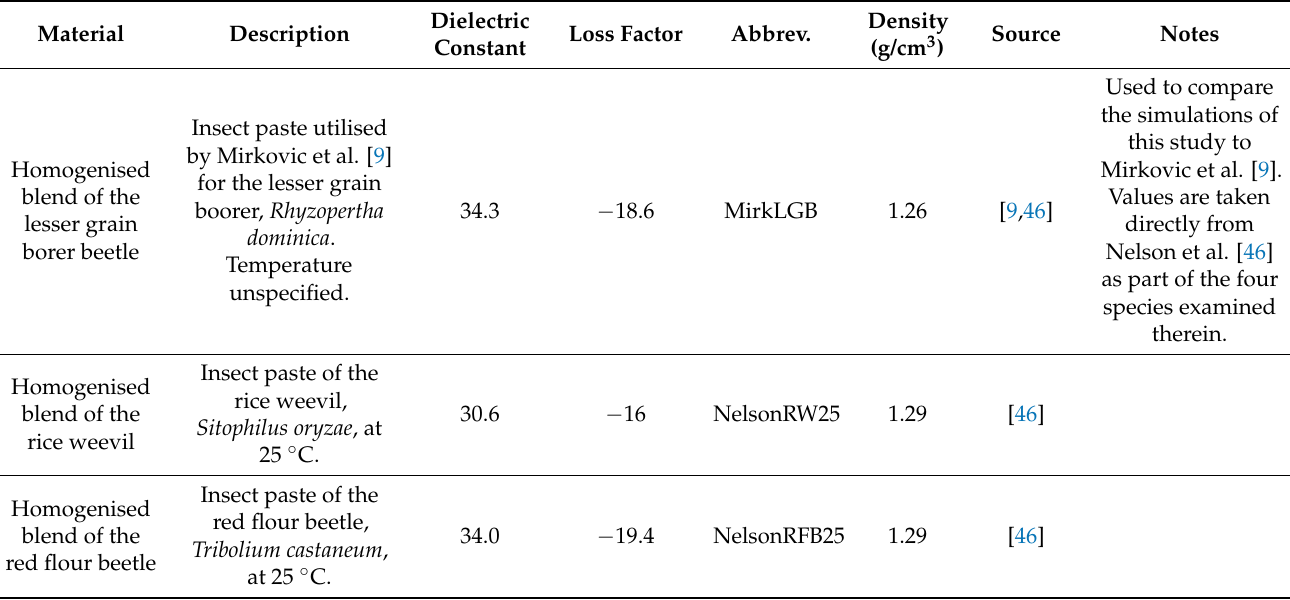
Figure 5. The three wing positions simulated as part of this study: ( a , b ) are referred to as “Up”, ( c , d ) are referred to as “Mid” and ( e , f ) are referred to as “Down”; ( a , c , e ) depict the left-hand lateral view along the anteroposterior aspect of the moth, whilst ( b , d , f ) depict the ventral aspect. Table 1. Dielectric constant and loss factors used in this study. All parameters are valid for 9.4